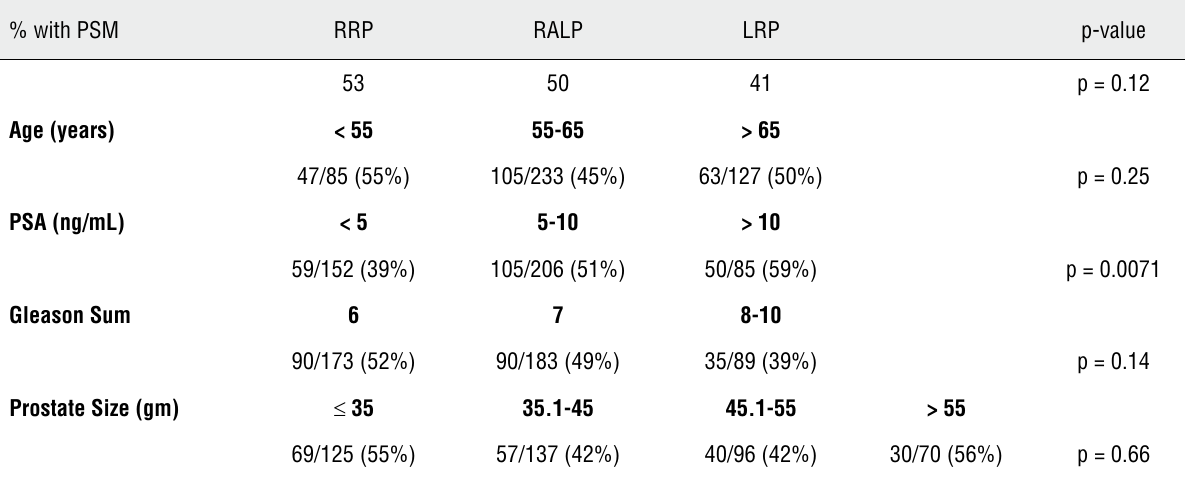
Table 3 - univariate analysis assessing variable association with PsM rate. % with